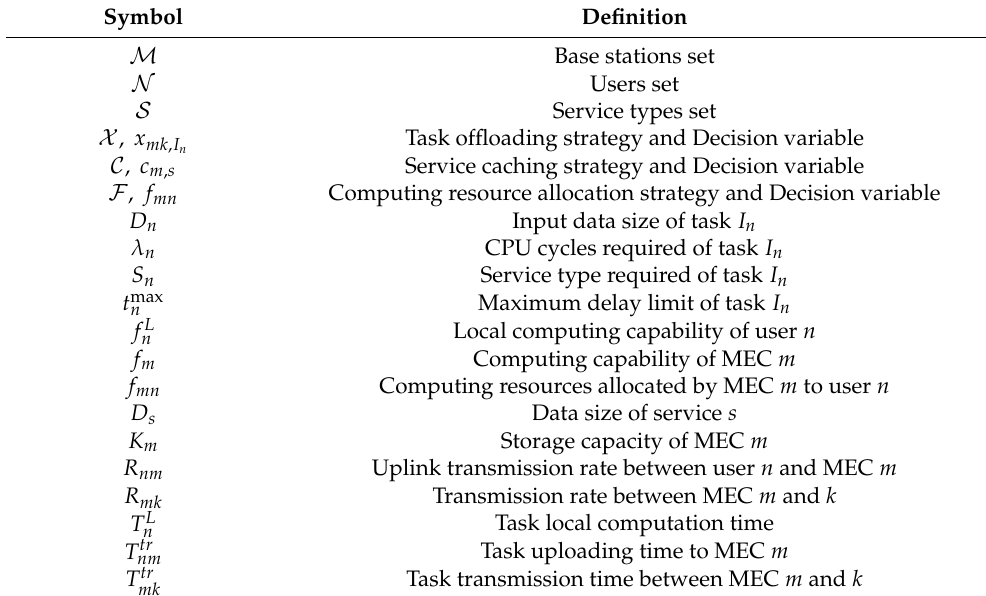
Table 1. Parameter